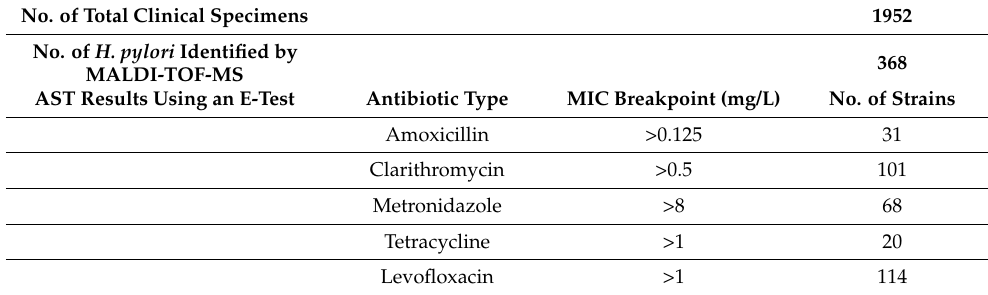
Table 1. Antibiotic susceptibility test for Helicobacter pylori identified from clinical